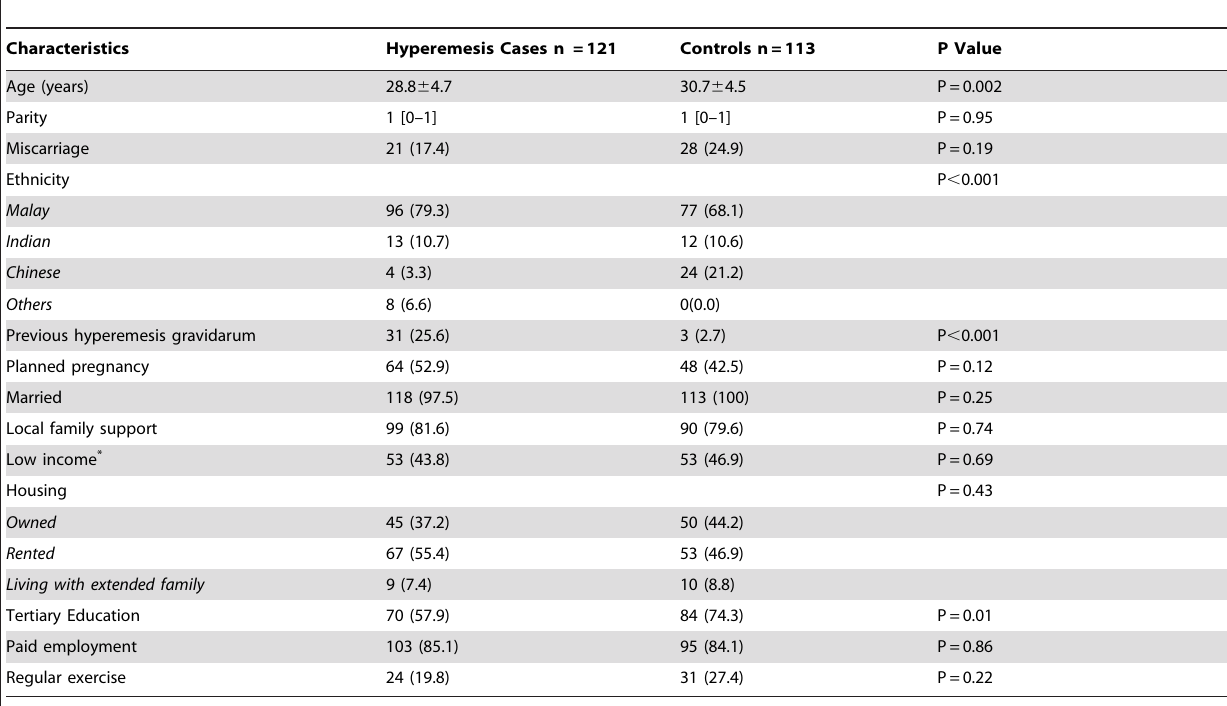
Table 3. Characteristics of hyperemesis gravidarum cases at hospitalization and of controls when recruited at 28 weeks.